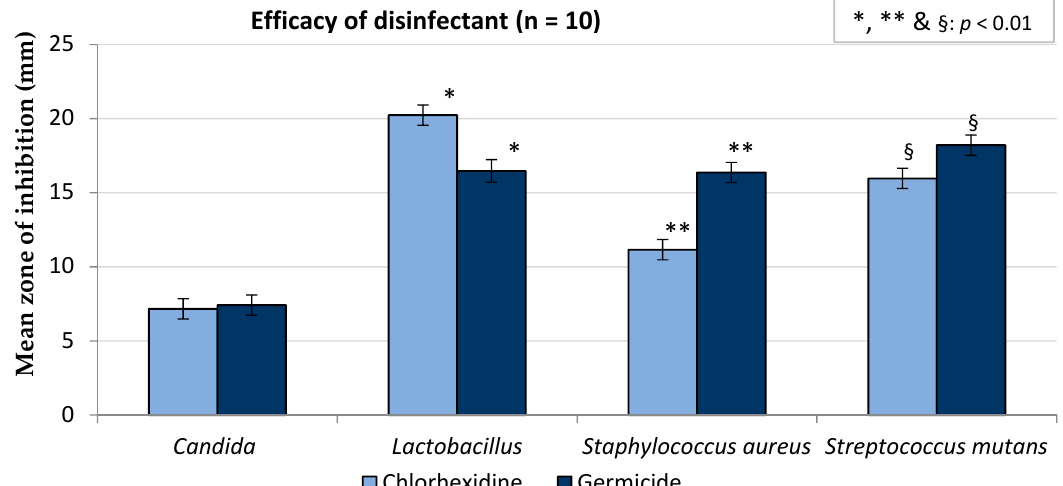
Figure 5. Antimicrobial activities of chlorhexidine gluconate and Germicide (error bars represent confidence intervals).